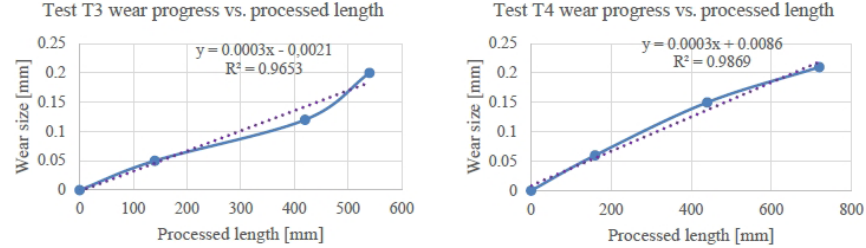
Figure 24. Wear progress versus the processed length, in case of test T3.